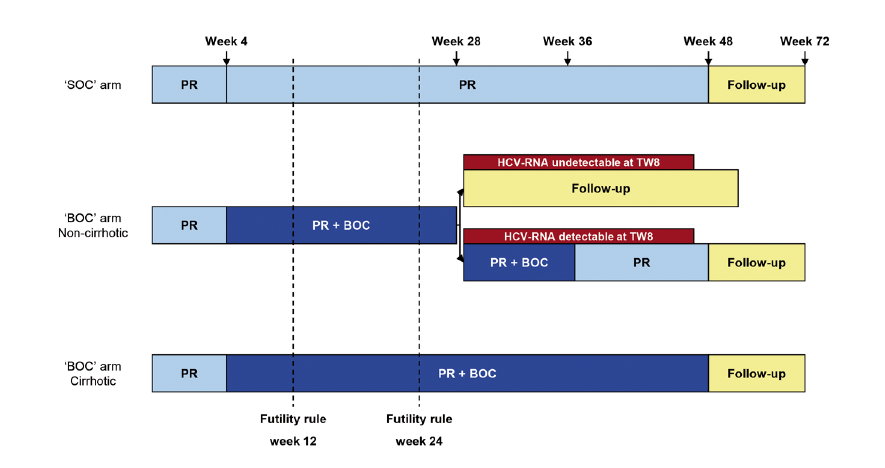
Figure 2. Treatment Strategies in the Model (Treatment-naive Patients)